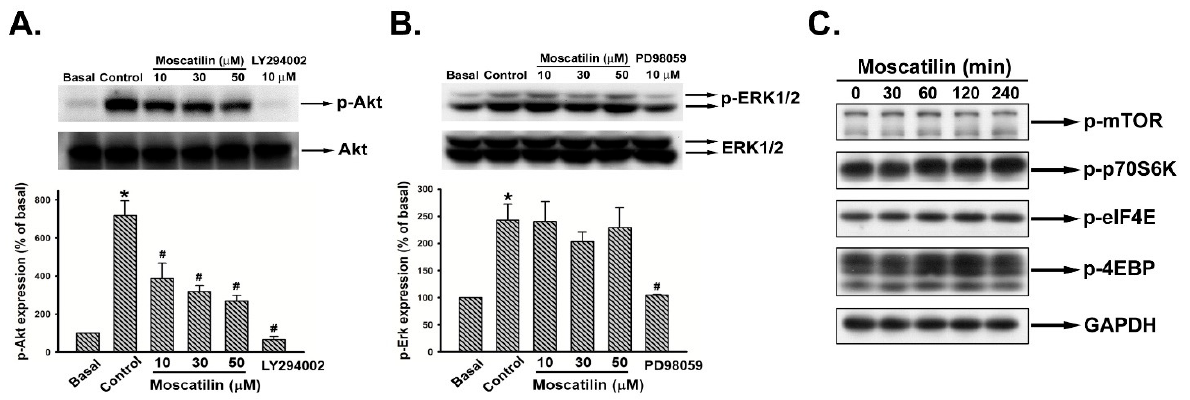
Figure 4. Effect of moscatilin on Akt, ERK, and translation pathways in human HCC cells. Serum-starved SK-Hep-1 cells were treated with vehicle (basal) or 10% FBS in the absence (control) or presence the indicated agents for 10 min. Cells were harvested and lysed for the detection of p-Akt ( A ) and p-ERK1/2 ( B ) by Western blot analysis. ( C ) SK-Hep-1 cells were treated with moscatilin (30 μ M) for the indicated time intervals, and p-mTOR, p-p70S6K, p-eIF4E, and p-4EBP were determined by Western blot analysis. The quantitative densitometry of the relative level of protein was performed with Image-Pro Plus. Data are expressed as mean ± SEM of five independent experiments. * p < 0.05 compared with the basal group. # p <0.05 compared with the control group.